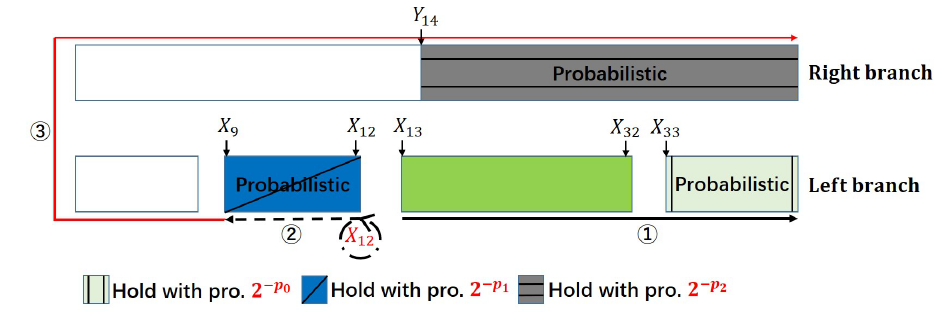
Figure 3: SFS collision attack framework for